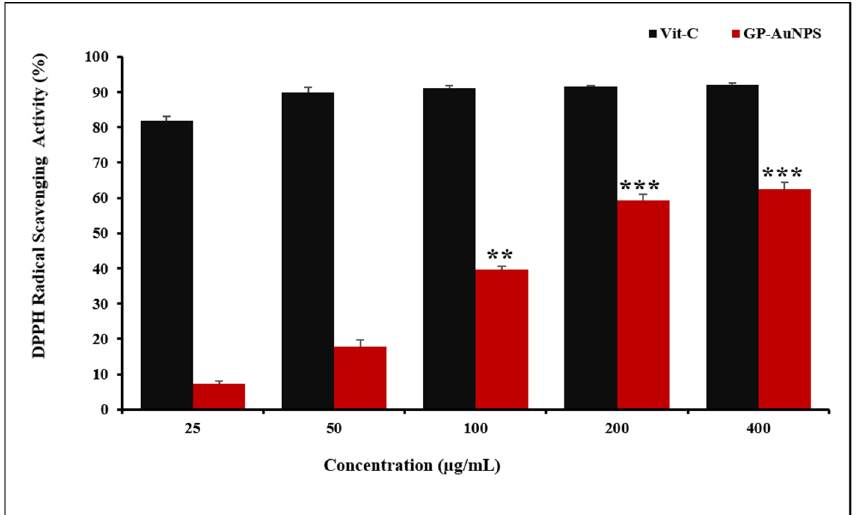
Figure 9. Dose-dependent in vitro DPPH radical scavenging and antioxidant activity of biosynthe- sized GP-AuNPs. Approximately 60% of DPPH inhibition was recorded at the 200 and 400 µ g/mL. The data shown represent the mean values of three experiments ± SD. ** p < 0.01, *** p < 0.001 as compared with the Vit-C.2.5. Effect of GP-AuNPs on the LPS-induced NO production.